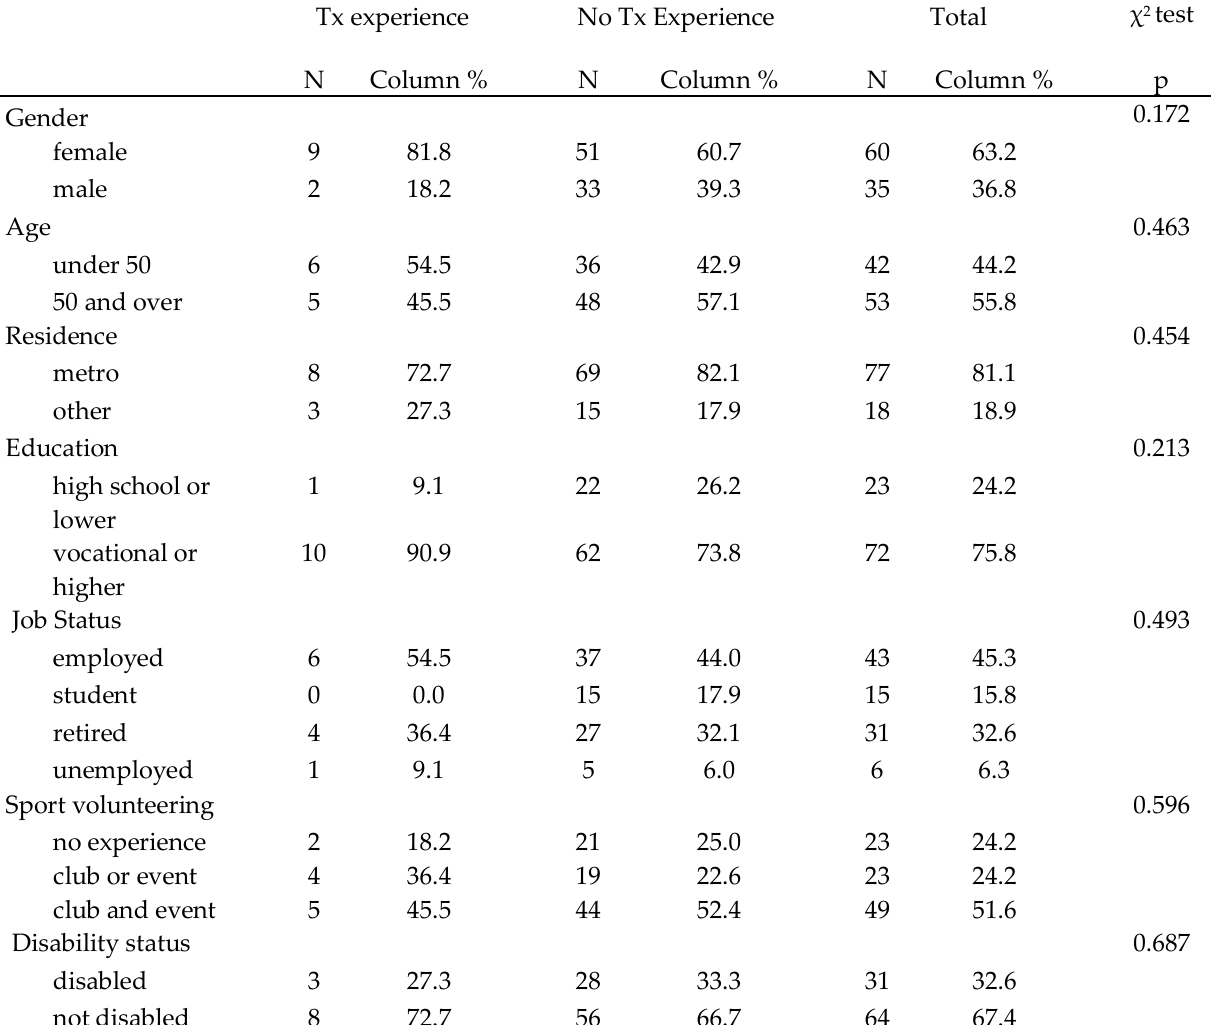
Table 2. Respondents with and without experience with